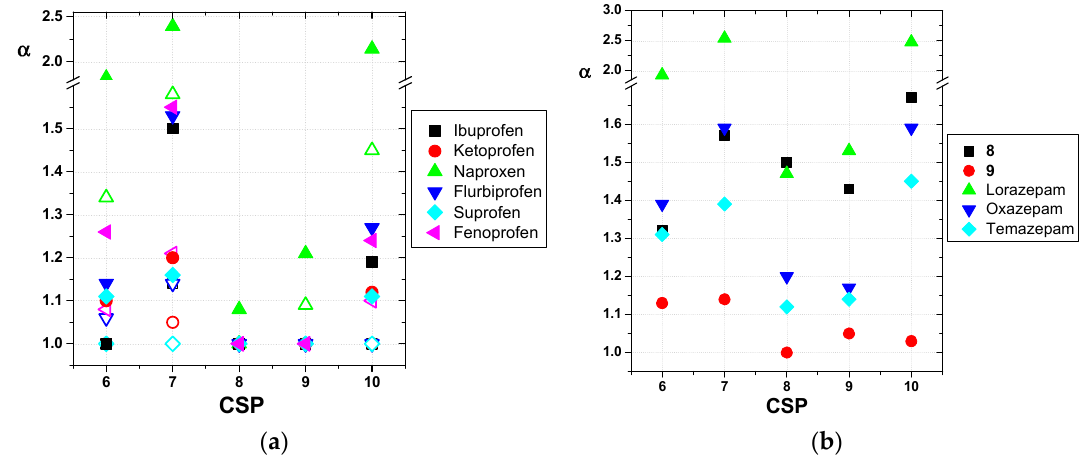
Figure 7. Structures of the tested non-steroidal anti-inflammatory drugs (NSAIDs) and 3-hydroxy- benzodiazepine drugs.